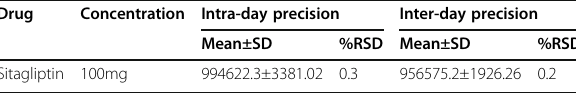
Table 3 Intra-day and inter-day precision of sitagliptin ( n =6) Drug Concentration Intra-day